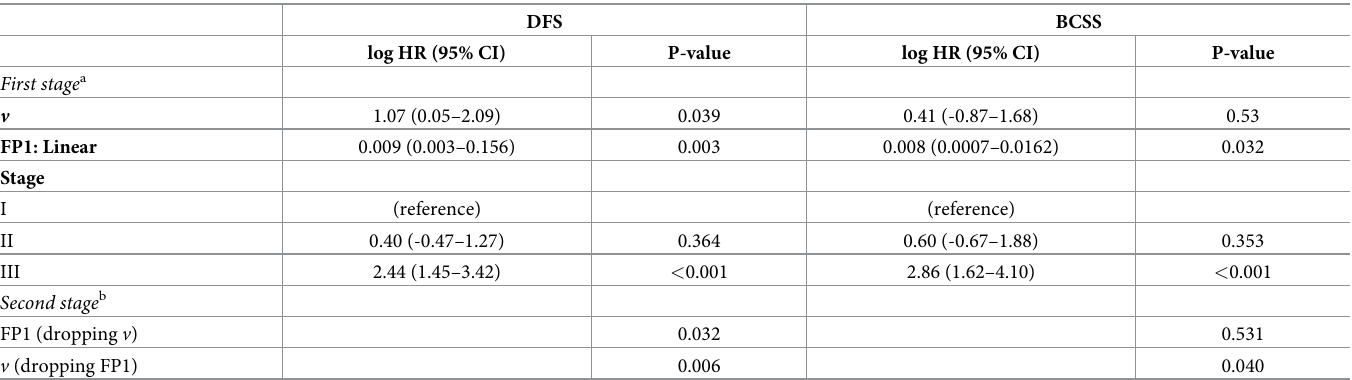
Table 7. Results from multivariate Cox models for DFS and BCSS using the FP-Spike approach for